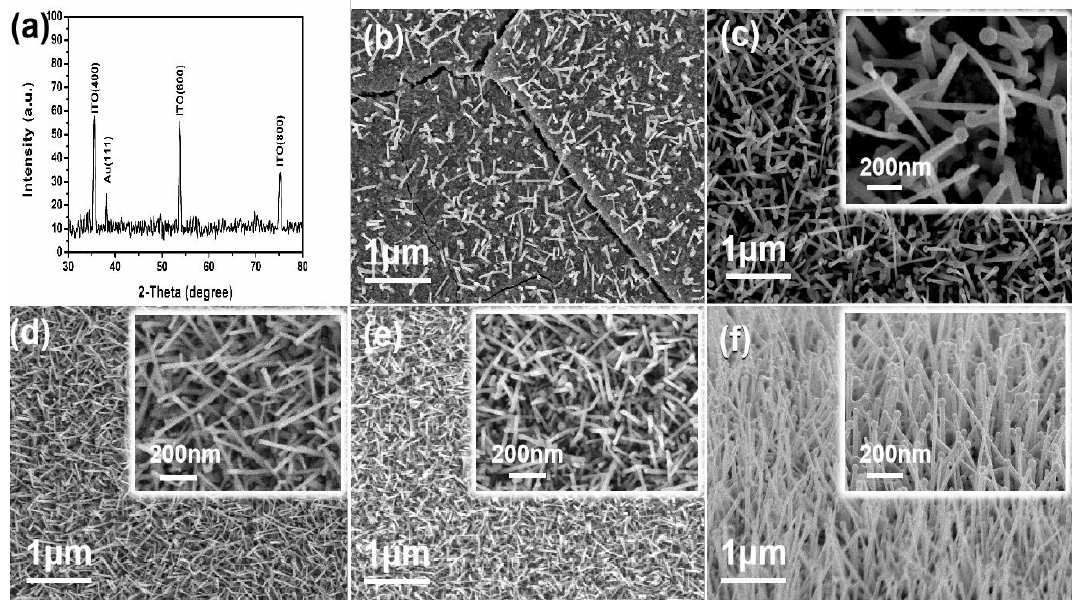
Figure 5. ( a ) XRD of ITO on the U-bent fiber. ( b – e ) ITO frontal images of ITO-NM/U-bent/0.04/12, ITO-NM/U-bent/0.04/16, ITO-NM/U-bent/0.04/20, and ITO-NM/U-bent/0.04/24. ( f ) The ITO frontal morphology of ITO-NM/U-bent/0.1/20.